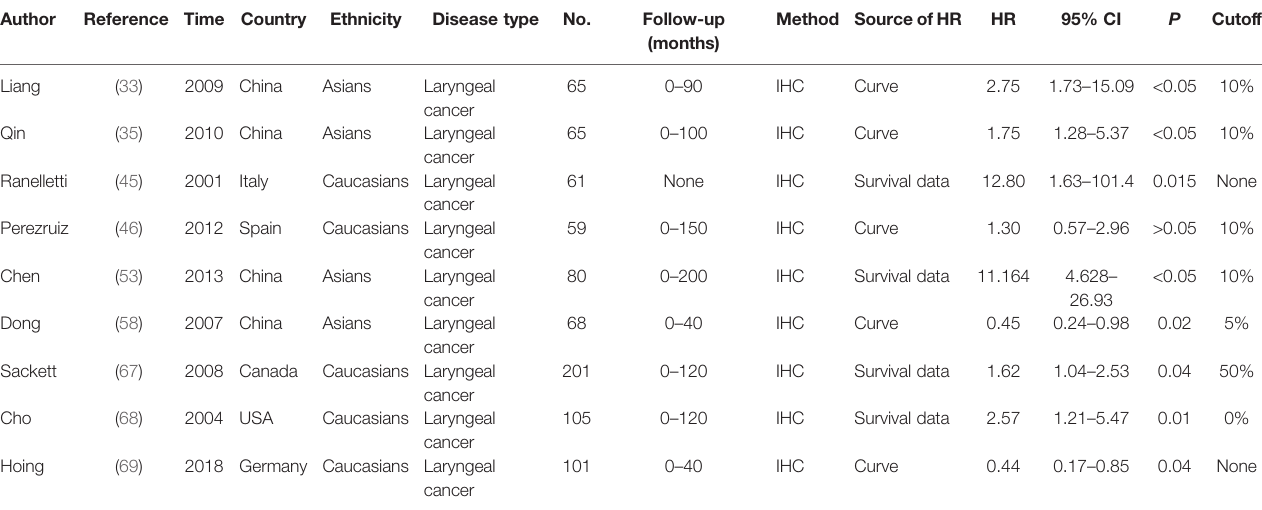
TABLE 2 | Characteristics of the included studies for overall survival of laryngeal cancer patients.